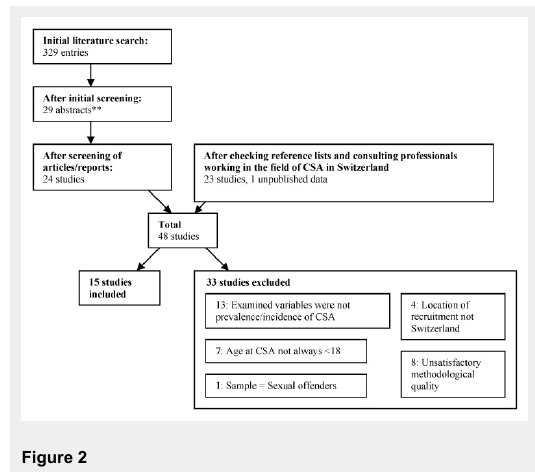
Keywords and Boolean operators used for database